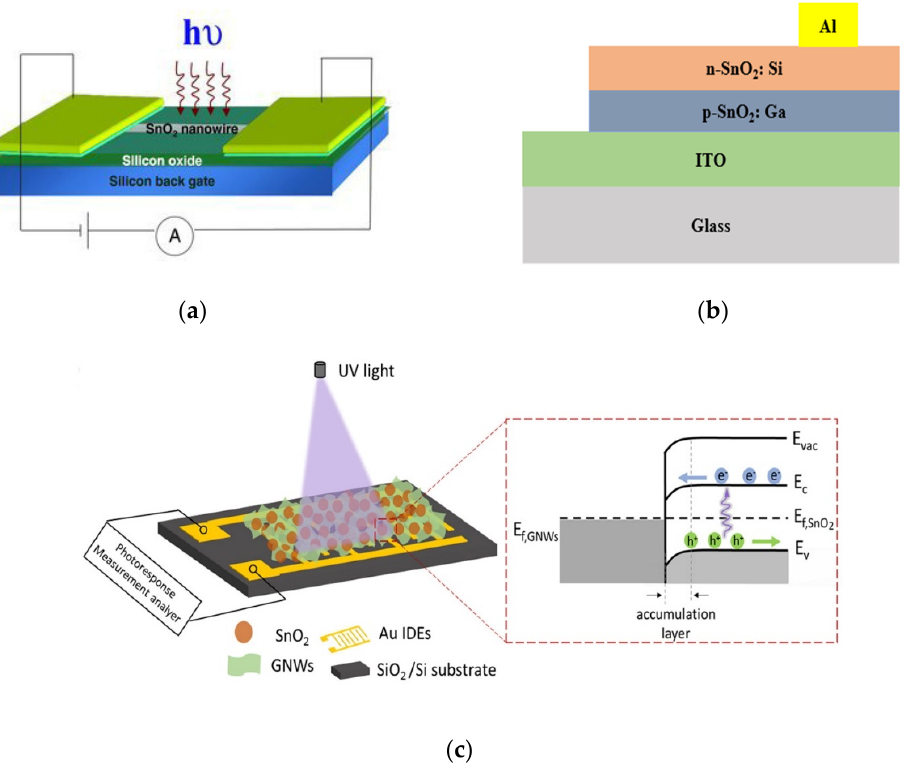
Figure 1. ( a ) SnO 2 nanowire UV detector structure diagram. Reproduced with permission from Ref. [47]; 2011, Wiley; ( b ) Schematic representation of Al/SnO 2 : Si/SnO 2 : Ga/ITO heterojunction photodiode [21]; ( c ) Structure diagram and working mechanism of GNWs/SnO 2 devices under UV light. Reproduced with permission from Ref. [48]; 2019, Elsevier.